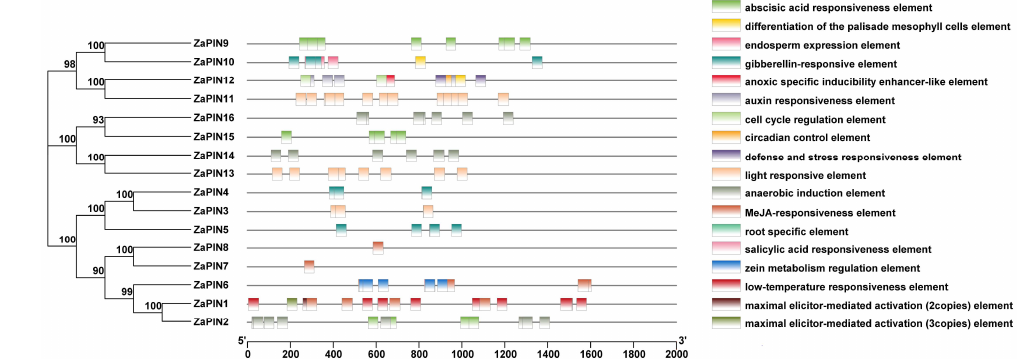
Figure 7. Analysis of cis -acting elements in ZaPINs promoters in Z. armatum .